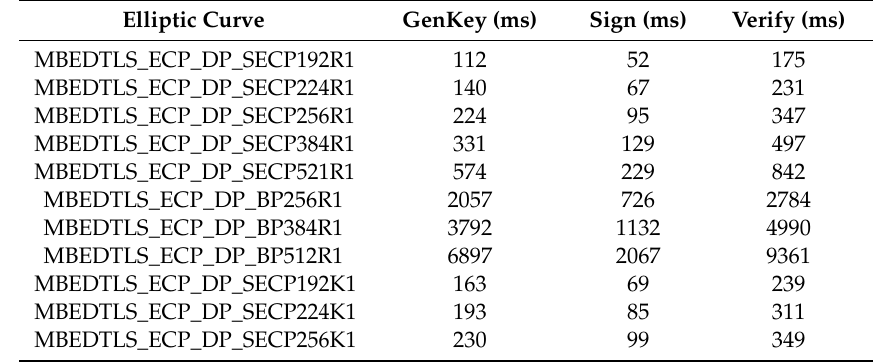
Table 4. Key generation, signature, and verification runtimes for various elliptic curves on the ESP32. Elliptic